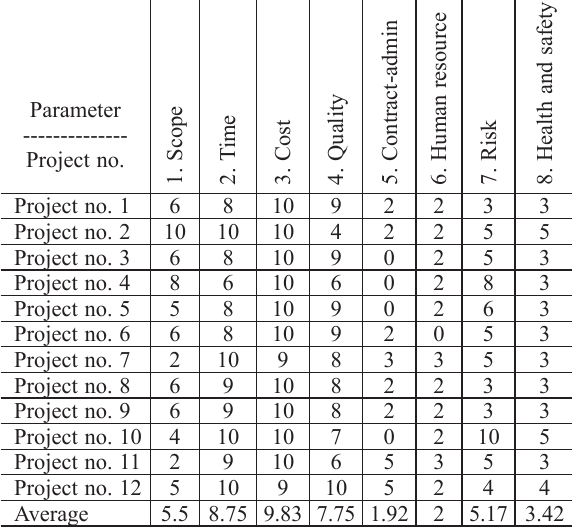
Parameter -------------- Project no.